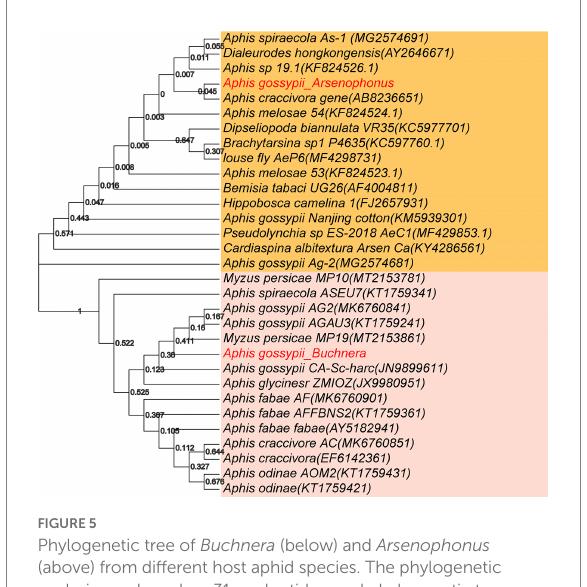
FIGURE 5 Phylogenetic tree of Buchnera (below) and Arsenophonus (above) from different host aphid species. The phylogenetic analysis was based on 31 nucleotides, and phylogenetic tree was constructed by the neighbor-joining through MEGA7.0 software with 1,000 Bootstrap replicates. GeneBank accession number of the 16S rRNA gene sequences of these two genera from different insects are listed in parentheses, respectively.